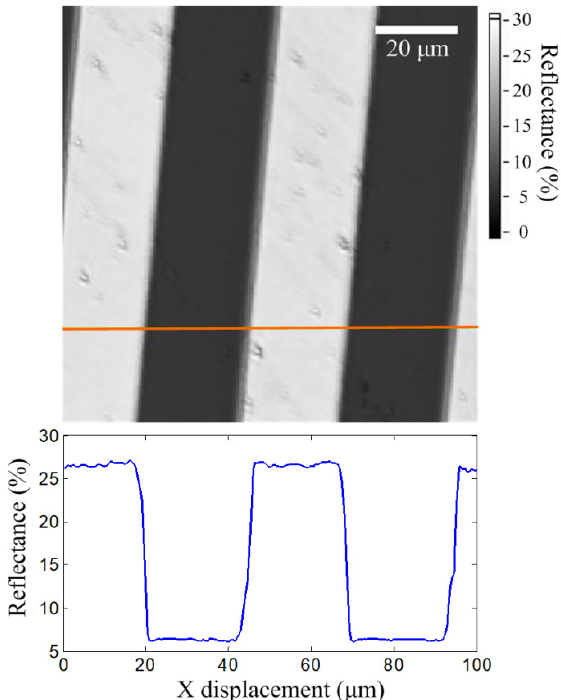
Figure 5. Real-time reflectance image on the grating R2L2S1N1.